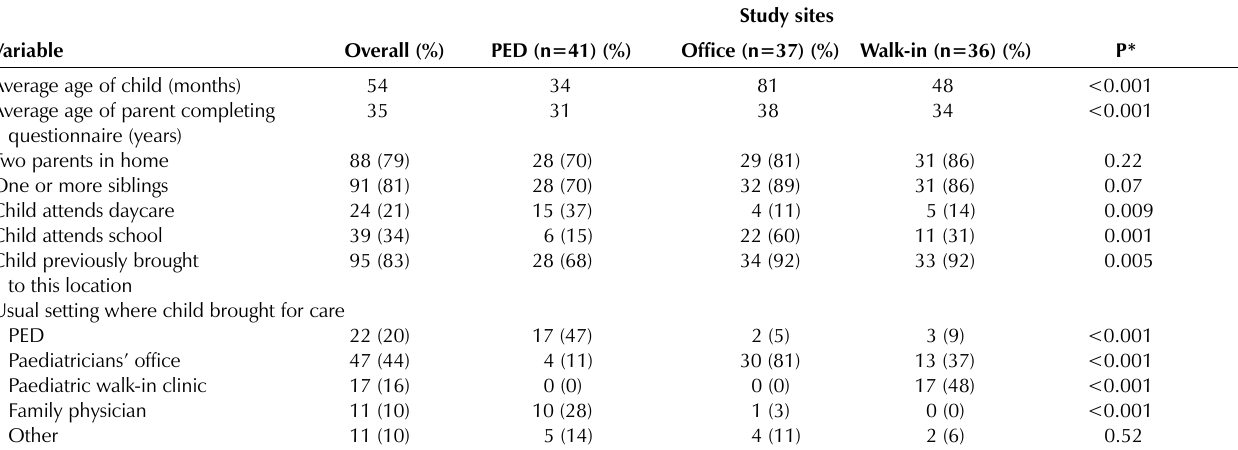
Demographic characteristics of groups participating in a survey of parents(cid:146) views on antibiotic use